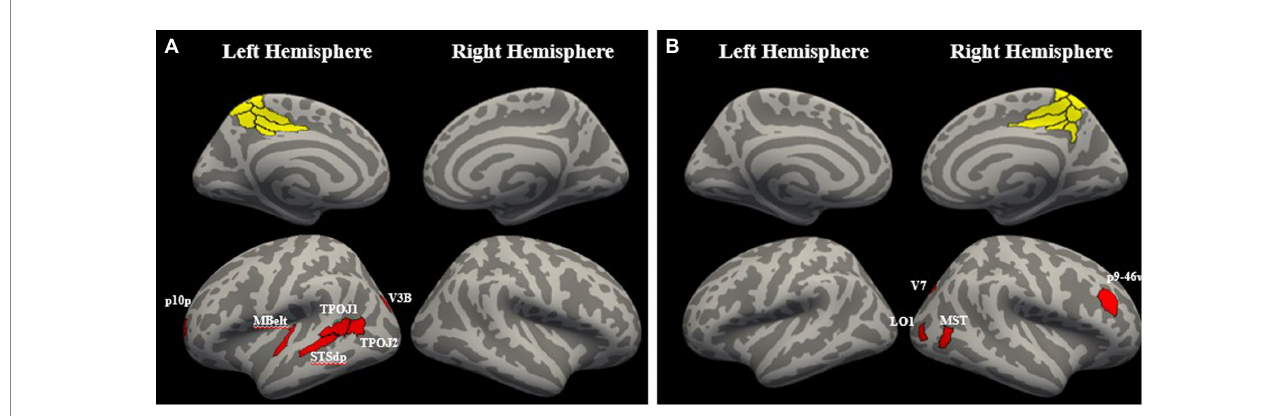
FIGURE 6 Regions with significant connectivity increases with attention. (A) The left hemisphere precuneus cluster had significant increases in theta phase connectivity with attention with left medial belt (MBelt), left dorsal posterior superior temporal sulcus (STSdp), left temporo-parieto-occipital junction 1 and 2 (TPOJ1 and TPOJ2), left visual area 3b (V3B), and posterior frontal pole area 10 (p10p; q < 0.1). (B) The right hemisphere precuneus cluster had significant increases in theta phase connectivity with attention with right medial superior temporal area (MST), right lateral occipital area 1 (LO1), right visual area 7 (V7), right posterior area 9-ventral area 46 in the dorso-lateral prefrontal cortex (p9-46v; q <